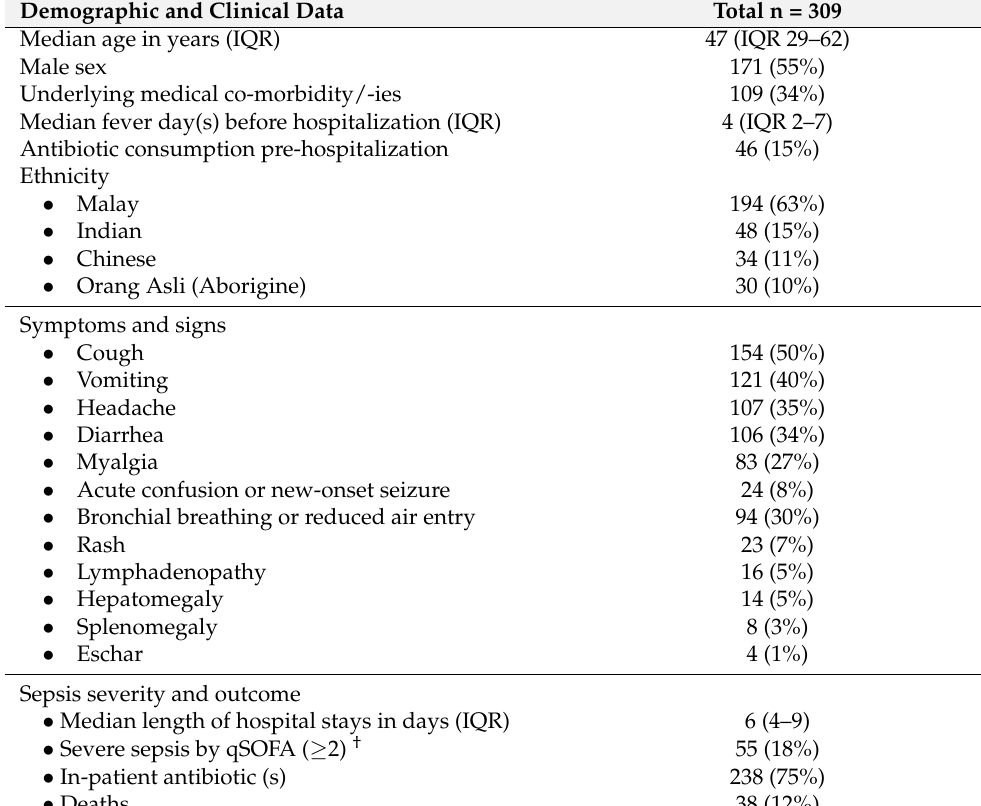
Table 1. Demographic and clinical data of 309 enrolled